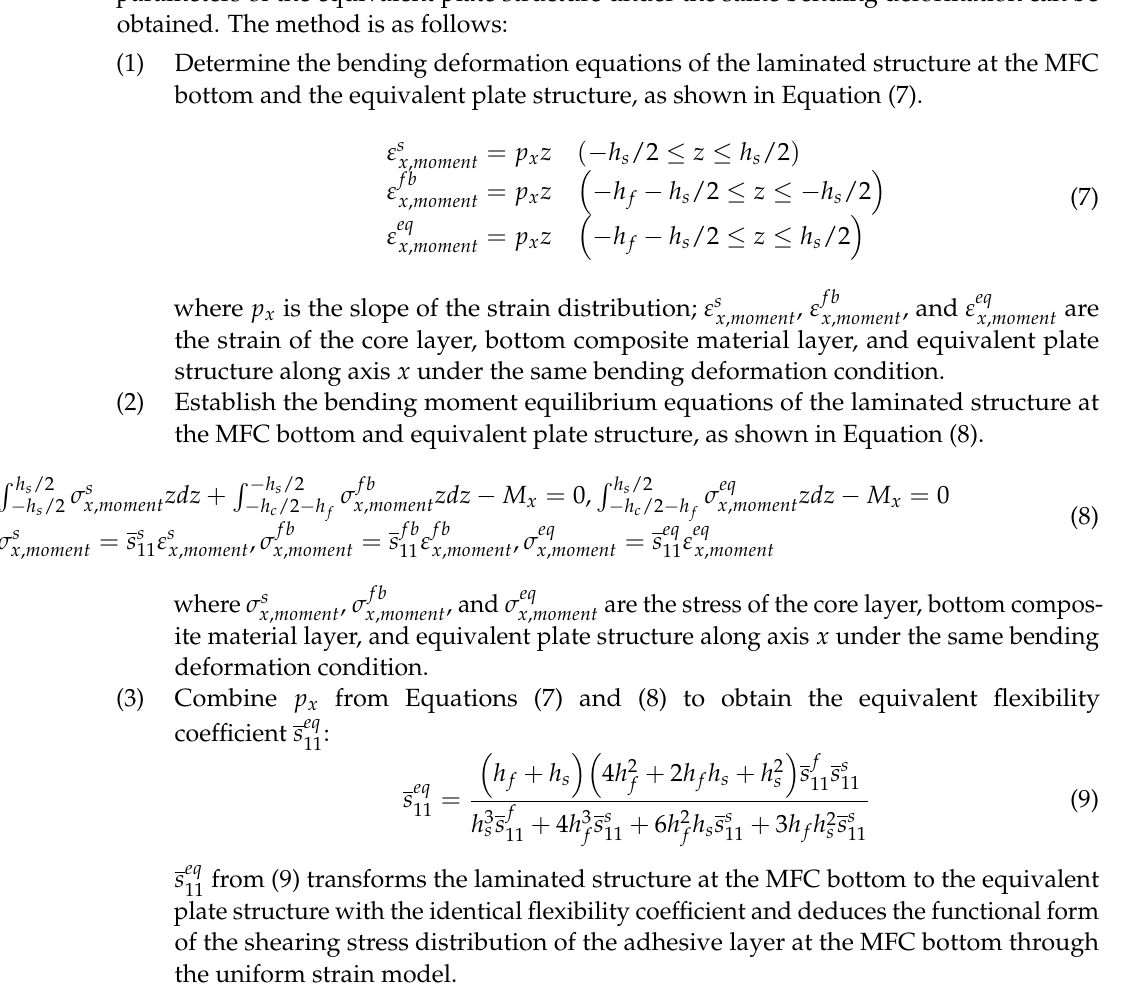
Figure 3. Actuating force transmission in embedded MFC. Due to the different material parameters of the lower MFC layers, it is inconvenient to use the uniform strain model to analyze the shear lag effect between the structure and the adhesive layer. Considering that the deformation effect of MFC on the sandwich panel structure is mainly reflected in the bending deformation, we adopt the equivalent material parameter solution method with consistent bending deformation, which requires presum ‐ ing an equivalent plate structure made of homogenous material. It has equally strong bending resistance to the laminated structure at the MFC bottom. If the curvature of the laminated structure is constant, and if the same bending moment is exerted onto the lam ‐ inated structure at the MFC bottom and the equivalent plate structure, the material pa ‐ rameters of the equivalent plate structure under the same bending deformation can be obtained. The method is as follows: